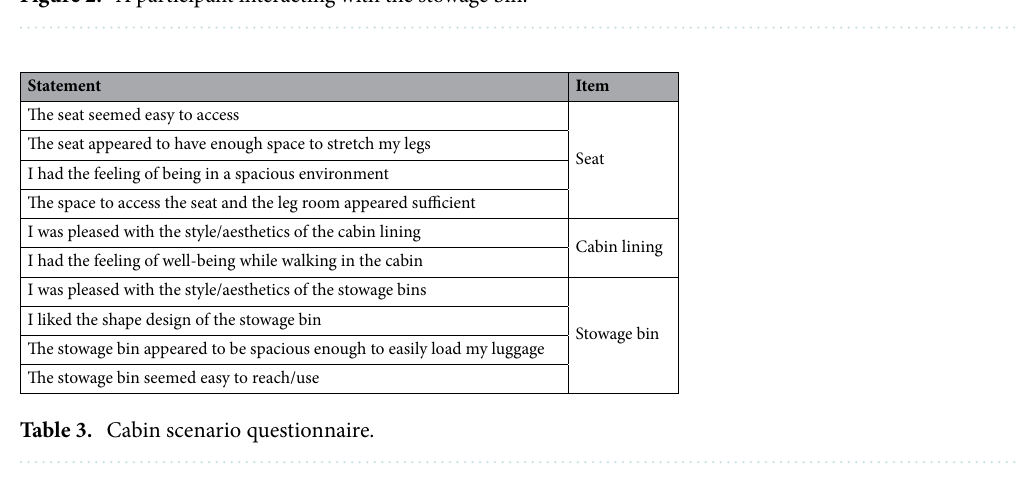
Figure 2. A participant interacting with the stowage bin.